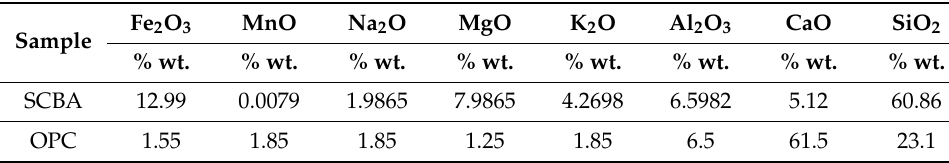
Table 4. Chemical composition of SCBA and OPC.